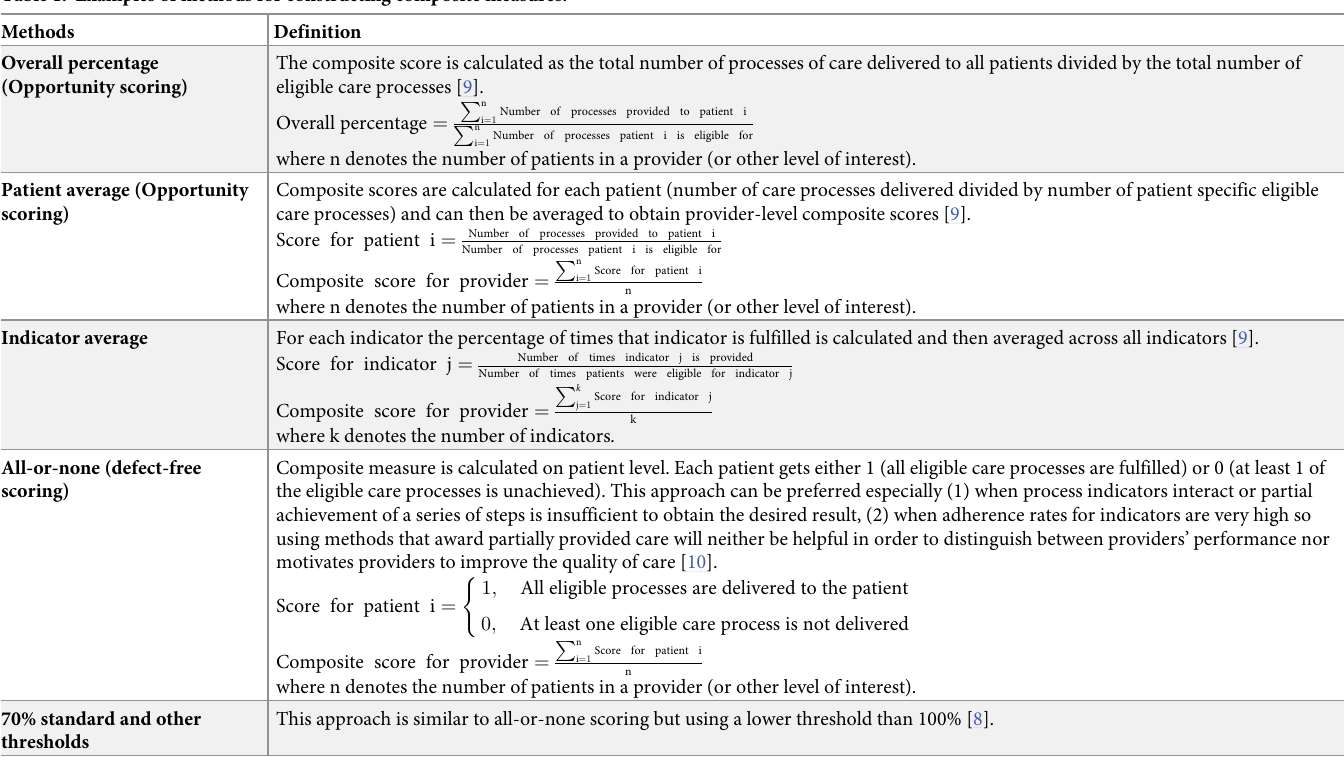
Table 1. Examples of methods for constructing composite